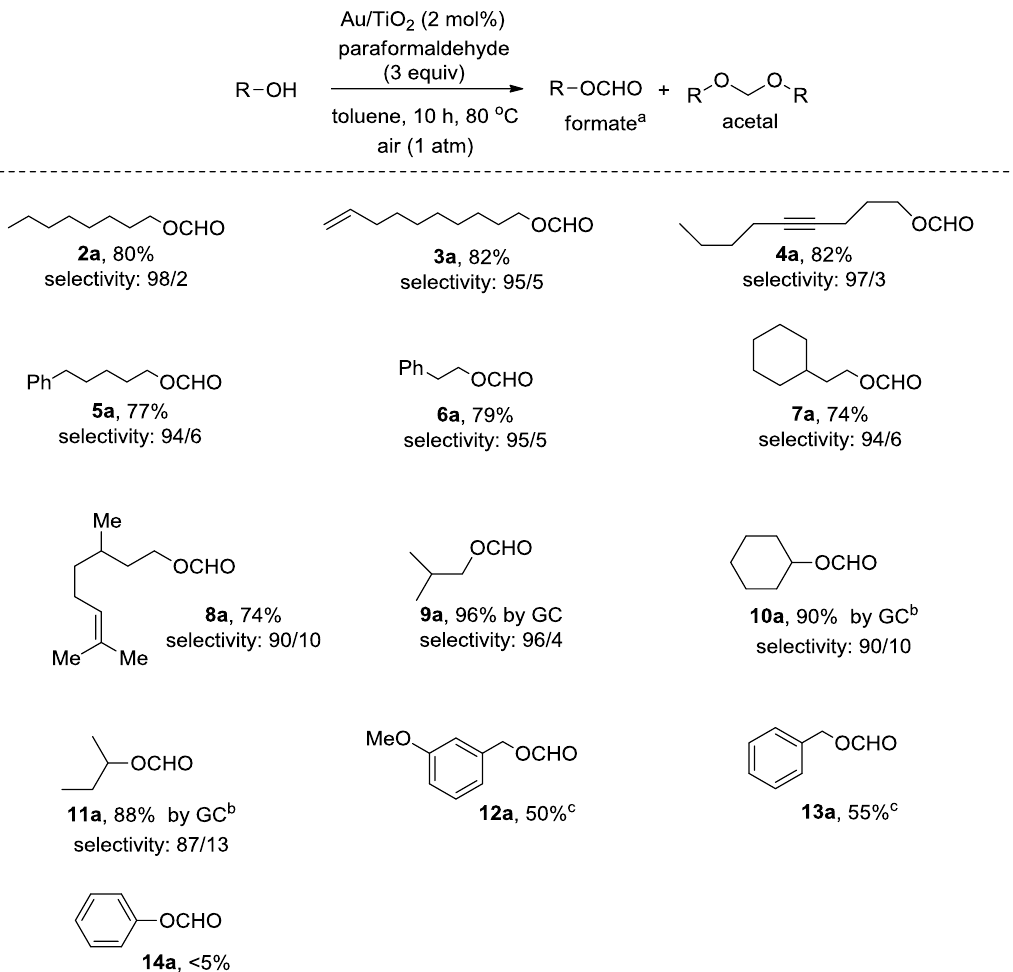
Figure 1. Formylation of alcohols via their aerobic oxidative coupling with paraformaldehyde catalyzed by Au/TiO 2 . a Isolated yields after column chromatography, except if referred as yields by GC. b Reaction time 18–22 h, 5 equiv of paraformaldehyde. c Side products from the partial oxidation of benzylic alcohols (~15%), acetalization of formaldehyde (~5–10%), and the formation of minor amounts of dibenzyl ethers (~10%) drops the yield of formates.